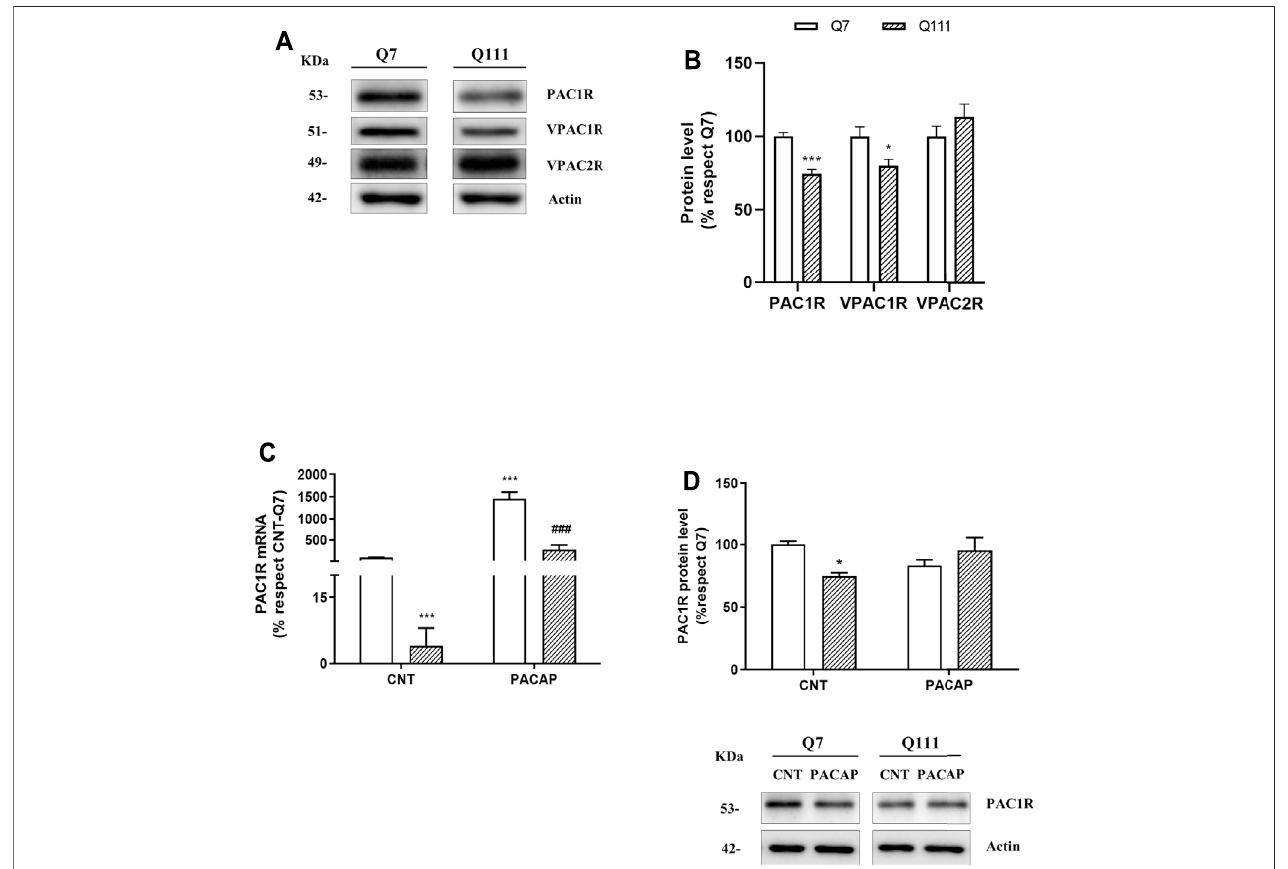
FIGURE 3 | PAC1R is reduced in STHdhQ111/Q111 cells and the addition of PACAP increases its mRNA levels. Protein levels ofPAC1R, VPAC1R, and VPAC2R were analyzed in STHdhQ7/Q7 (Q7) and STHdhQ111/Q111 (Q111) cells by Western blot. (A) Representative immunoblots are shown. Quanti fi cation of (B) PAC1R, VPAC1R, and VPAC2R was performed. The results (mean ± SEM; n (cid:1) 5) were normalized to the loading control actin and are expressed as a percentage respect to Q7 cells. Then, STHdhQ7/Q7 (Q7)and STHdhQ111/Q111(Q111) cells weretreatedwith PBS(CNT)orPACAP (10-7M) for24 hours (C) mRNAlevels ofPAC1R were analyzed using quantitative RT-PCR. The results (mean ± SEM; n (cid:1) 5) were normalized to GAPDH and are expressed as a percentage respect to CNT-Q7 cells. (D) Protein levels of PAC1R were studied by Western blot. The results (mean ± SEM; n (cid:1) 5) were normalized to the loading control actin and are expressed as a percentage respect to CNT-Q7 cells. Representative immunoblots are shown. In (B) , comparison of receptors ’ protein levels between Q7 and Q111 was analyzed by using Student ’ st-test.In (C) and (D) ,datawereanalyzed byusingtwo-way ANOVAfollowedbyTukeyaspost-hoc test. * p < 0.05*** p < 0.001ascompared toCNT-Q7cells; ### p < 0.001 as compared to CNT-Q111